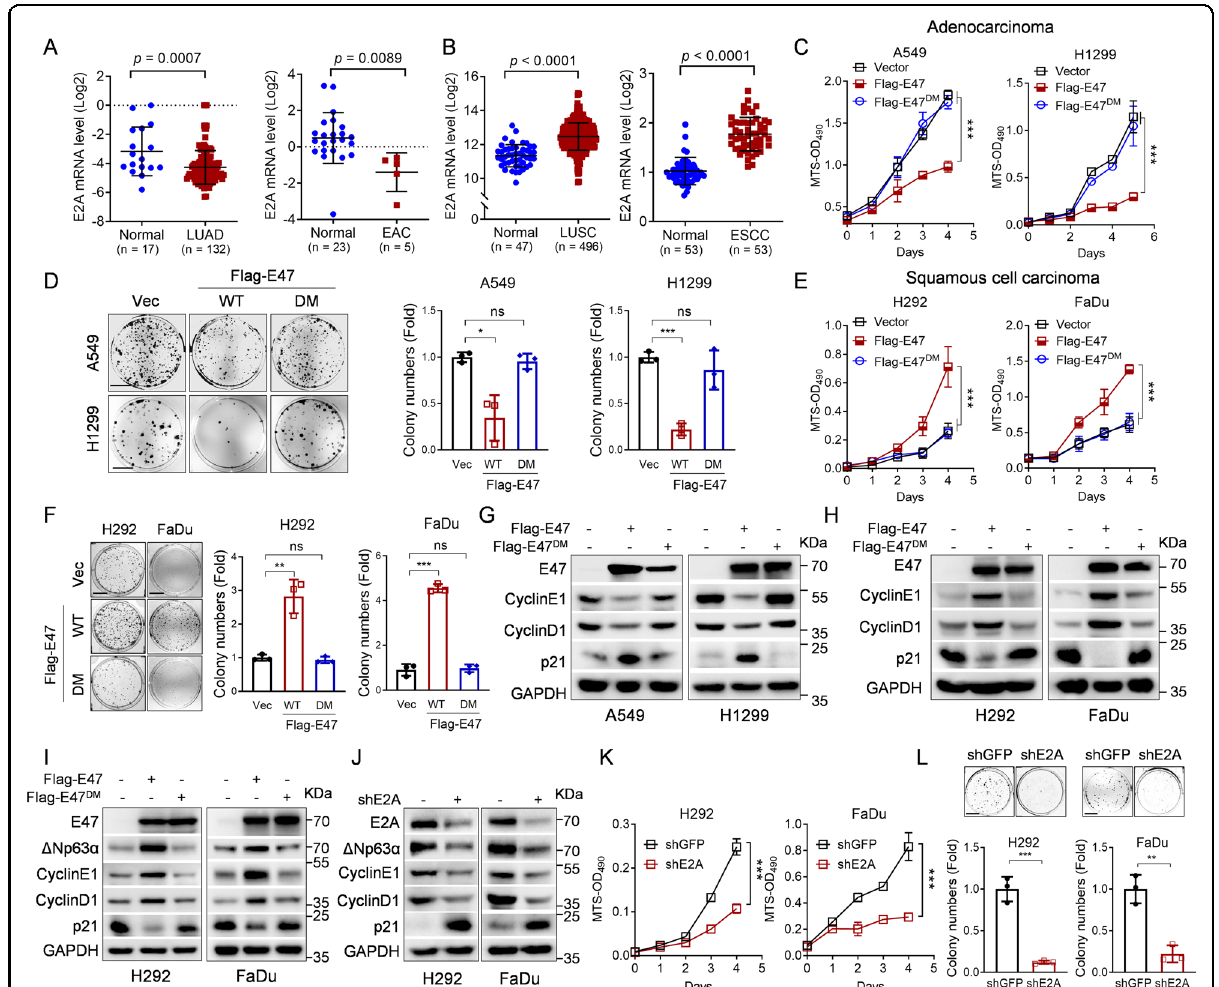
Fig. 1 E47 upregulates Δ Np63 α expression and promotes squamous carcinoma cell proliferation. A The Oncomine dataset “ Hao_Esophagus ” or “ Bhattacharjee_Lung ” was used to analyze E2A mRNA levels in normal tissues and human esophagus adenocarcinoma (EAC) or lung adenocarcinoma (LUAD). B The Oncomine dataset “ Su_Esophagus ” or “ TCGA ” was used to analyze E2A mRNA levels in normal tissues and human esophagus squamous cell carcinoma (ESCC) or lung squamous cell carcinoma (LUSC). C – H A549, H1299, H292, or FaDu cells stably expressing wild- type Flag-E47, Flag-E47 DM mutant (E47 A592N/I596D ) or a vector control were subjected to MTS assays ( C , E ), Colony formation analyses ( D , F ), or Western blot analyses ( G – H ). Scale bar = 1 cm. Three independent experiments were performed. Data were presented as mean ± SD. * p < 0.05, ** p < 0.01, *** p < 0.001. I H292 or FaDu cells stably expressing wild-type Flag-E47, Flag-E47 DM mutant, or a vector control were subjected to Western blot analyses. J – L H292 or FaDu cells stably expressing shRNAs against E2A ( + ) or GFP ( − ) were subjected to Western blot analyses ( J ), MTS assays ( K ), or Colony formation analyses ( L ). Scale bar = 1 cm. Three independent experiments were performed. Data were presented as mean ± SD. ** p < 0.01, *** p <